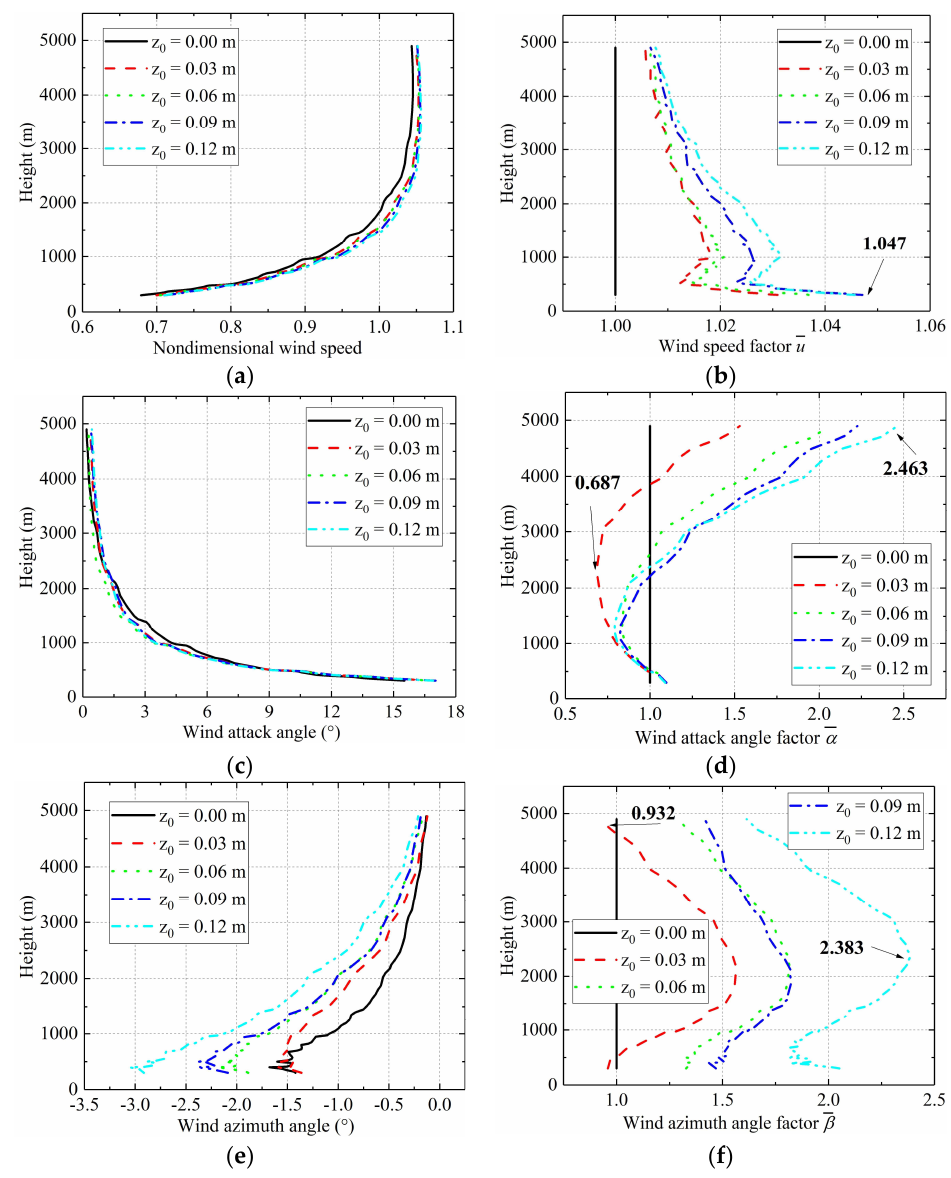
Figure 5. Influence of surface roughness on wind parameters: ( a ) Nondimensional wind speed profile; ( b ) Nondimensional wind speed factor; ( c ) Wind attack angle profile; ( d ) Wind attack angle factor; ( e ) Wind azimuth angle; ( f ) Wind azimuth angle factor.